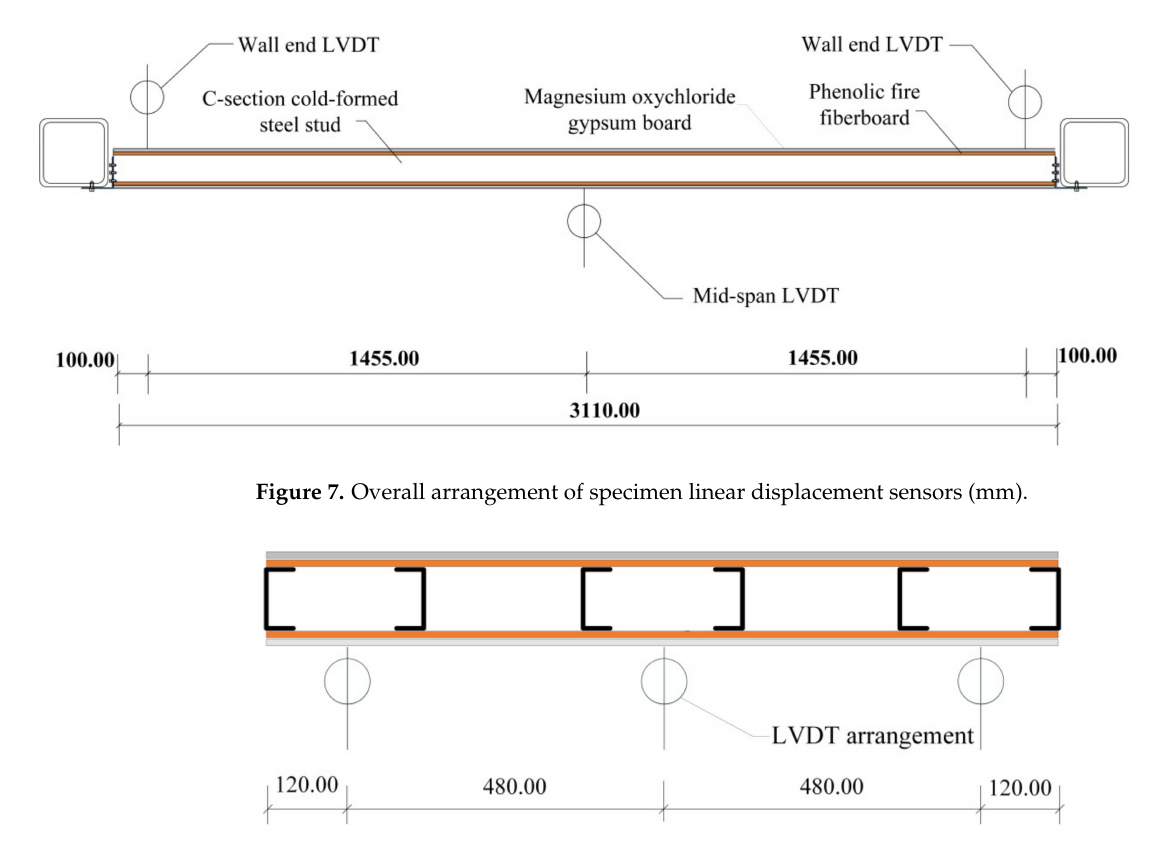
Figure 8. Mid-span linear displacement sensors.